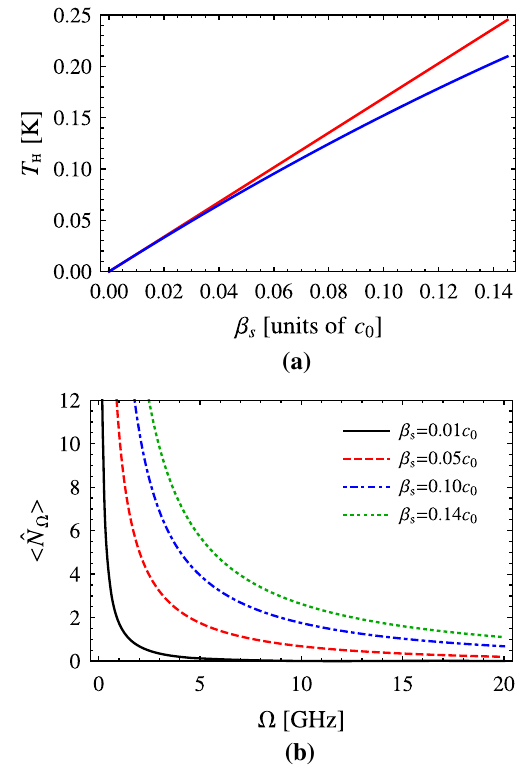
Fig. 2 a The temperature of analogue Hawking radiation observed in comovingframe(redsolidline)andinlaboratoryframe(bluesolidline); b the radiation spectrum of Eq. (5) as a function of particle frequency seen from the comoving frame. Note that the radiation spectrum seen fromthelaboratory,whichisnotshown, justhasveryslightlyquantitive